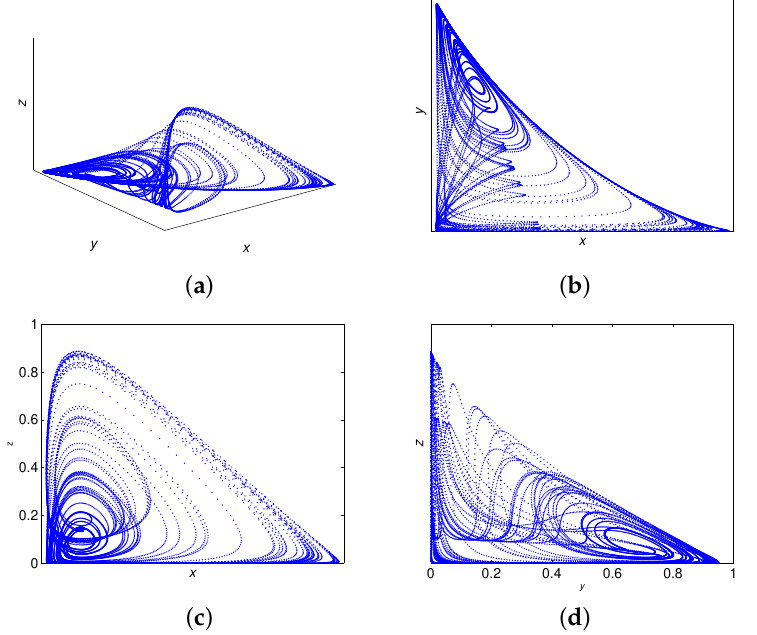
Figure 9. ( a ) Strange attractor of system (6) with the Taylor method and h = 0.1. ( b – d ) Projection of the attractor to system (6) onto the planes by each variable x , y , and z . ( a ) Strange attractor; ( b ) host cells: X = x ; ( c ) immune effector cells: X = y ; ( d ) tumor cells: X = z